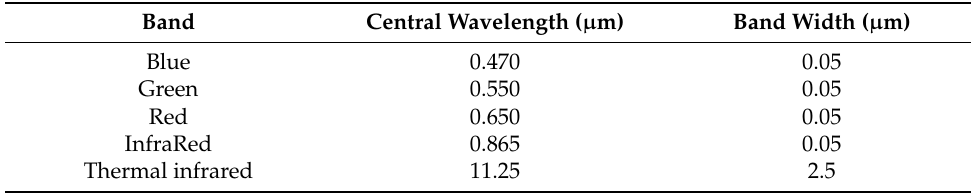
Table 1. Characteristics of MERSI 250-m bands from FY-3 satellites.